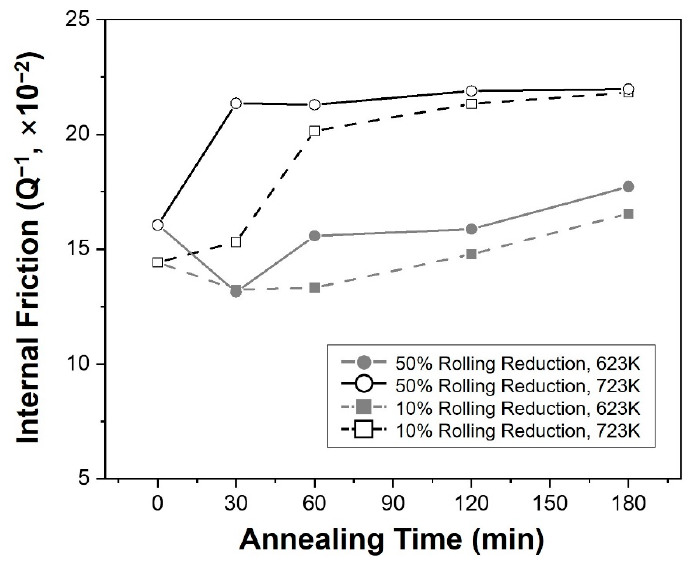
Figure 10. Graph showing the internal friction of specimens before and after the annealing process along with the annealing time. along with the annealing